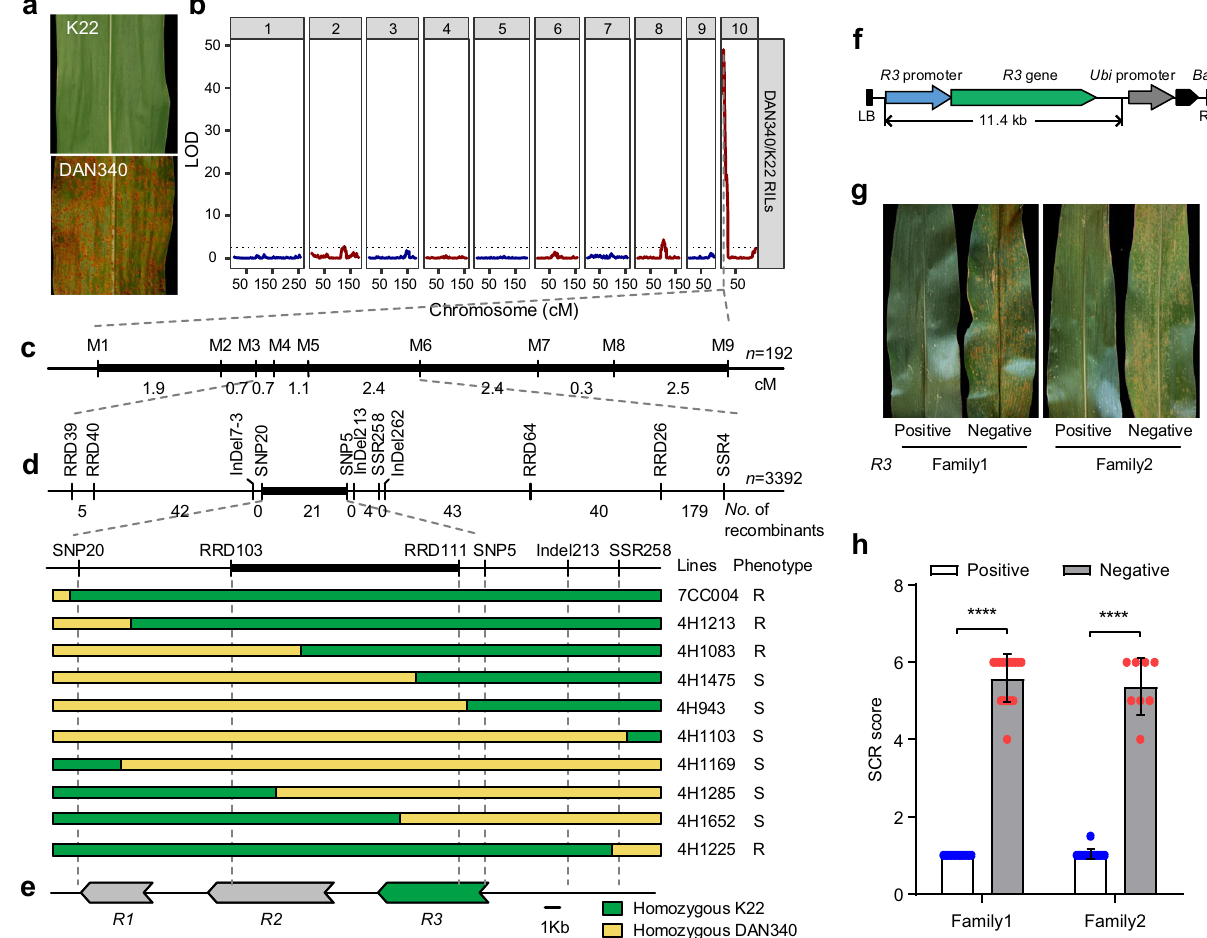
Fig. 1 | Map-based cloning of the RppK gene, conferring resistance against southern corn rust. a Southern corn rust (SCR) disease phenotypes of maize inbred lines K22 and DAN340. b SCR-related QTL locations in the genetic popula- tion of DAN340/K22 RILs. LOD, logarithm of odds. c The linkage mapping of the RppK locus based on 192 families delimited it to the region between markers M3 and M6. The numbers below the black rectangle indicate the relative genetic dis- tance (cM) between markers. d High-resolution linkage analysis performed by genotyping3392plantsofaheterogeneousinbredfamily(HIF)delimited RppK toa 15.2kb interval fl anked by markers RRD103 and RRD111. The number of recombi- nants is shown below the markers. Green segments represent the K22 allele, and yellow segments represent the DAN340 allele. The names of lines and the corre- sponding phenotypes are provided next to the haplotype. R, resistant; S,